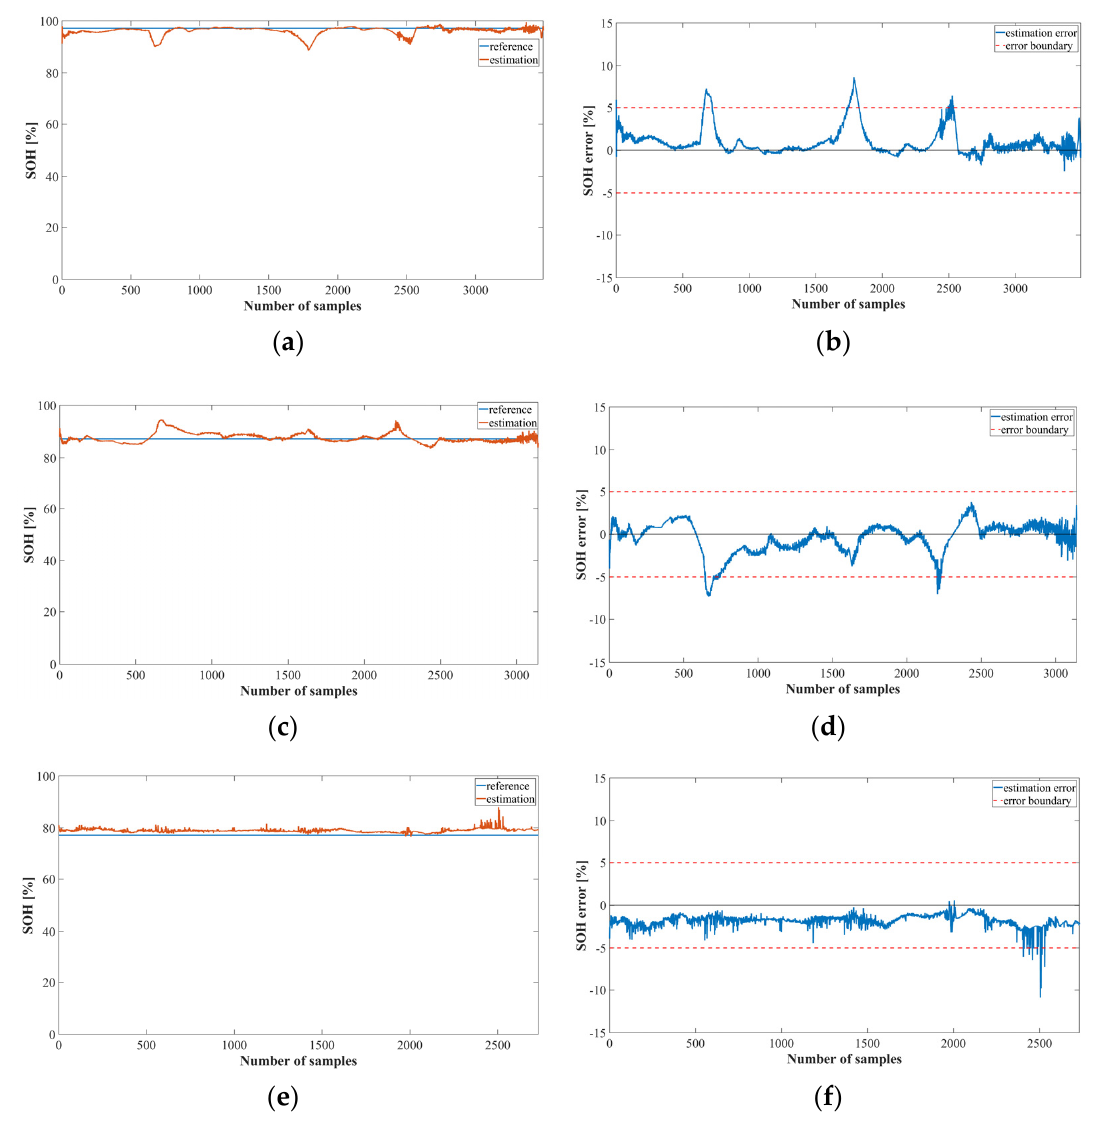
Figure 15. SOH estimation results using the proposed Method 2 with MNN and the Oxford dataset: ( a ) SOH estimation result at 6 cycles; ( b ) SOH estimation error at 6 cycles; ( c ) SOH estimation result at 28 cycles; ( d ) SOH estimation error at 28 cycles; ( e ) SOH estimation result at 70 cycles; ( f ) SOH estimation error at 70 cycles.